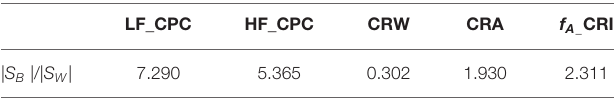
TABLE 5 | The divergence analysis of the features of CPC and CRI in the sleep classification task.